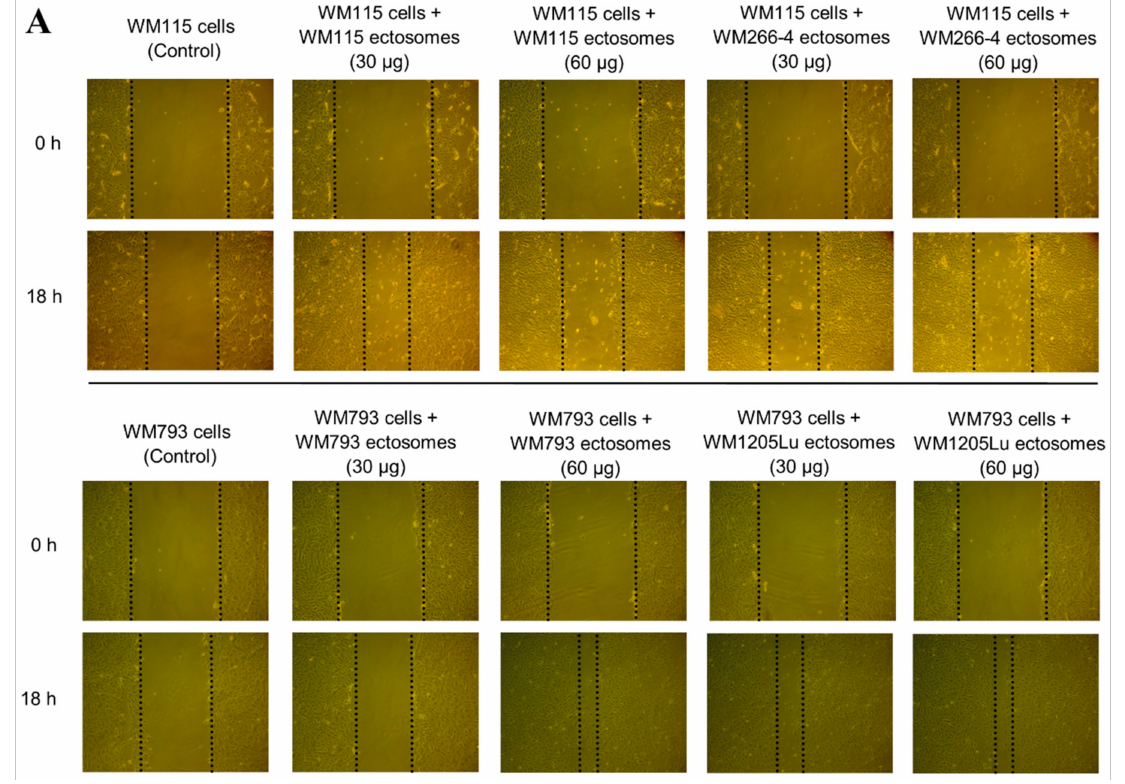
categories for ectosomes from all or metastatic cell lines are presented on the graph. Ectosomes were isolated from WM115 (primary) and WM266-4 (metastatic) cell lines originating from the same individual, radial / vertical growth phase and lymph node metastasis, respectively; primary WM793